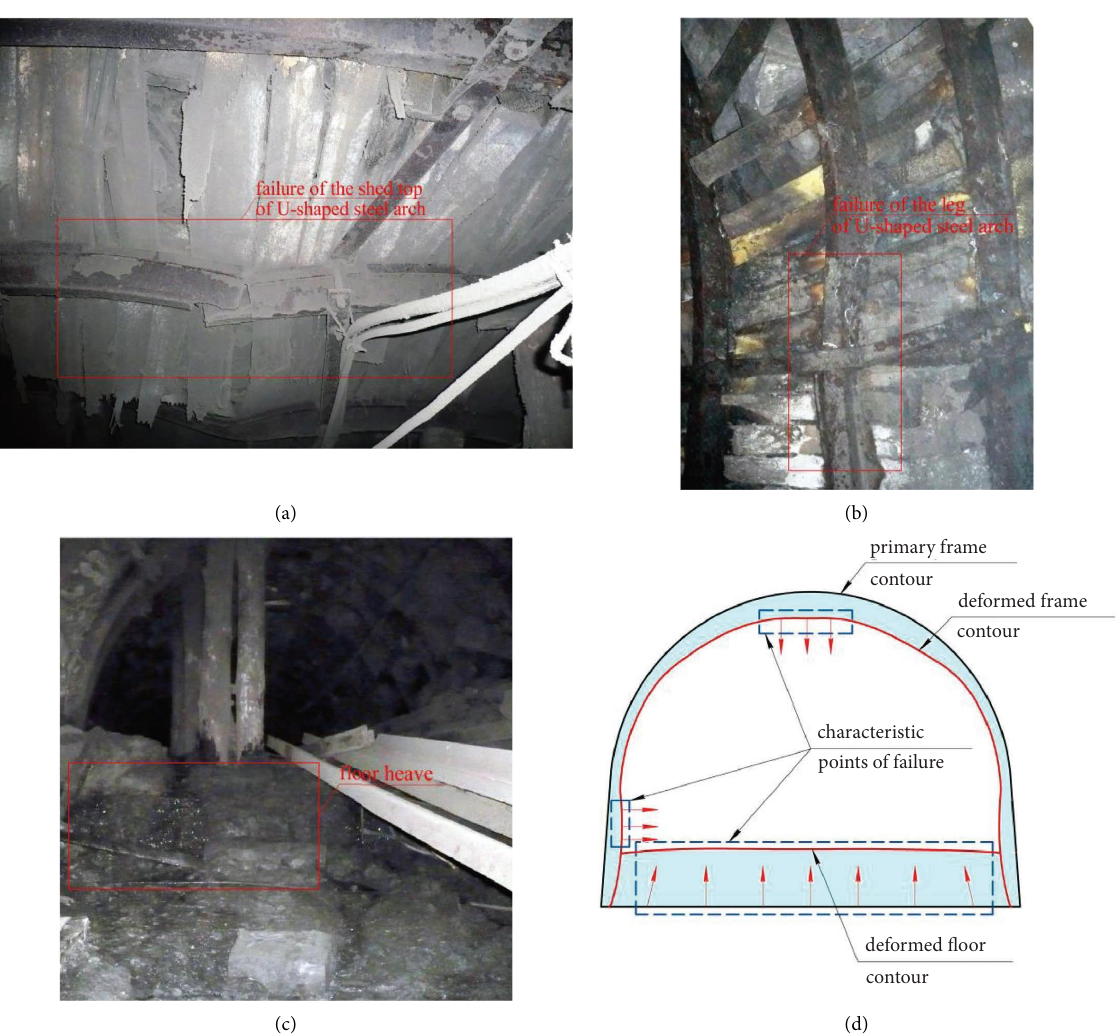
Figure 2: Te characteristics of rupture of the roadway: (a) the failure of the shed top of the U-shaped steel arch; (b) the failure of the leg of the U-shaped steel arch; (c) the foor heave; (d) the characteristic failures of the studied roadway.